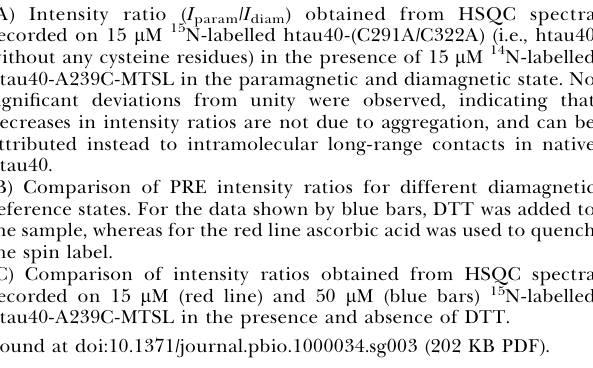
Figure S2. Robustness of Residual Secondary Structure of htau40 in Solution (A),(C),(D), Comparison of C a secondary chemical shifts, D C a , observed in htau40 and the tau fragments K32, K25, and K10, respectively (all at 5 8 C). (B) Comparison of C a secondary chemical shifts, D C a , observed in htau40 at 278K and 293K. Red lines indicate y ¼ x . Figure S3. Control PRE Measurements (A) Intensity ratio ( I param / I diam ) obtained from HSQC spectra recorded on 15 l M 15 N-labelled htau40-(C291A/C322A) (i.e., htau40 without any cysteine residues) in the presence of 15 l M 14 N-labelled htau40-A239C-MTSL in the paramagnetic and diamagnetic state. No significant deviations from unity were observed, indicating that decreases in intensity ratios are not due to aggregation, and can be attributed instead to intramolecular long-range contacts in native htau40. (B) Comparison of PRE intensity ratios for different diamagnetic reference states. For the data shown by blue bars, DTT was added to the sample, whereas for the red line ascorbic acid was used to quench the spin label. (C) Comparison of intensity ratios obtained from HSQC spectra recorded on 15 l M (red line) and 50 l M (blue bars) 15 N-labelled htau40-A239C-MTSL in the presence and absence of DTT. Found at doi:10.1371/journal.pbio.1000034.sg003 (202 KB PDF). Figure S4. Average Contact Map for the Seven Lowest-Energy Structures Obtained from Ensemble Calculations with an Ensemble Size of 5 (see Materials and Methods) A continuous grey scale from 3 A˚ (black) to 22 A˚ (white) is used. Found at doi:10.1371/journal.pbio.1000034.sg004 (2.14 MB